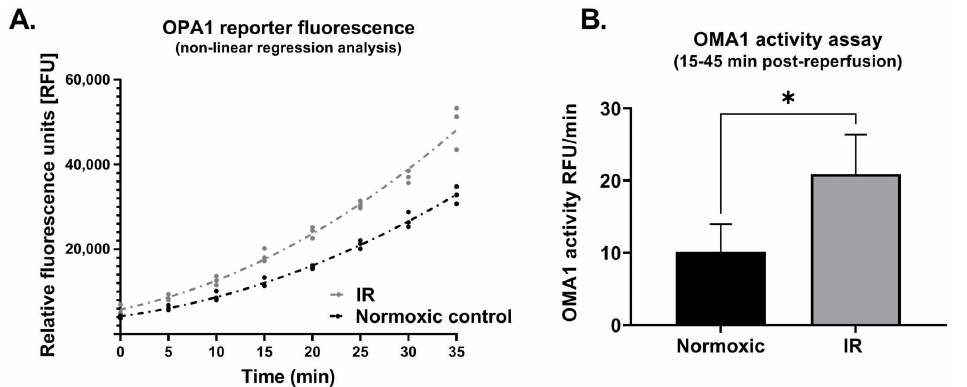
Figure 4. Protocol 2B: OMA1 protease activity is increased following reoxygenation. Panel ( A ): Non-linear regression analysis of OPA1 fluorogenic reporter peptide cleavage (assayed using a fluorescent reporter substrate: see Methods) in HL-1 cells subjected to simulated IR or a time-matched period of normoxia. Panel ( B ): OMA1 activity, assessed by quantifying initial reaction velocities (see Methods) was greater in cells subjected to simulated IR versus normoxia (* p < 0.05). n = 3 replicates per group. IR = simulated ischemia-reoxygenation.